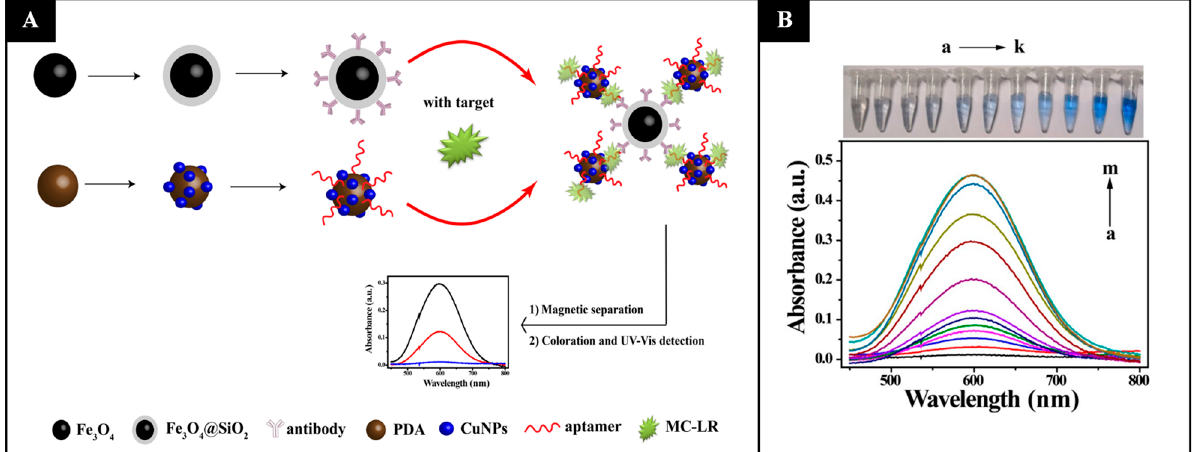
Figure 2. ( A ) Schematic representation of microcystin-LR detection using a colorimetric method based on magnetic separation and copper nanoparticle conversion to Cu 2+ ions, which then react with bis(cyclohexanone)oxaldihydrazone. ( B ) This reaction gives rise to a blue solution, whose color intensity increases with the concentration of microcystin-LR (nmol L − 1 ): ( a ) 0, ( b ) 0.05, ( c ) 1.0, ( d ) 2.0, ( e ) 3.0, ( f ) 4.0, ( g ) 5.0, ( h ) 10.0, ( i ) 15.0, ( j ) 20.0, ( k ) 25.0, ( l ) 30.0, and ( m ) 35.0. (Reproduced under the terms and conditions of Creative Commons Attribution (CC BY) license